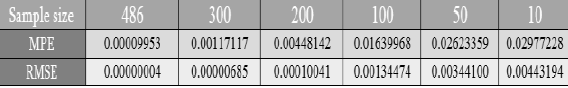
Table 1: The effects of sample size on the accuracy of the predictions.